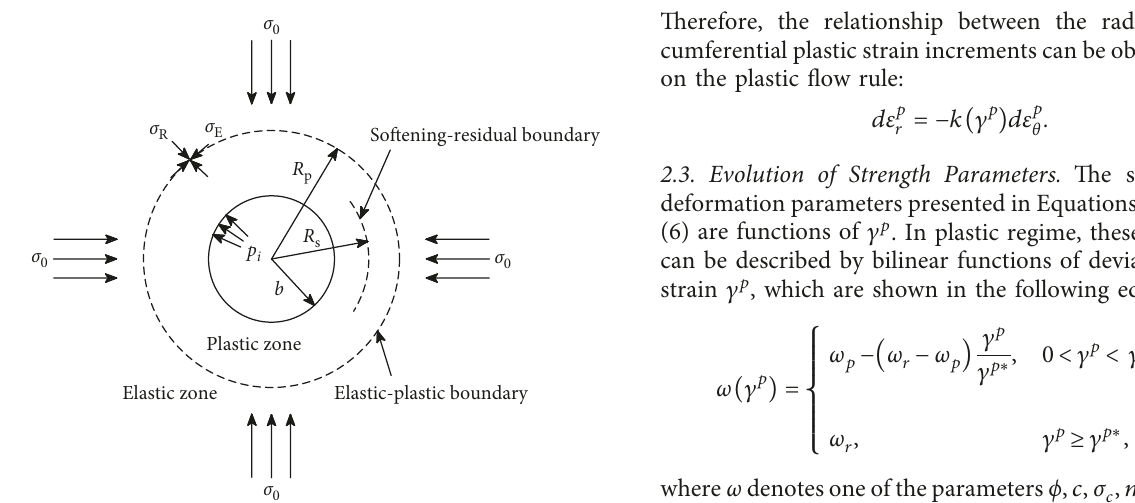
Figure 1: Plastic zone formed around circular